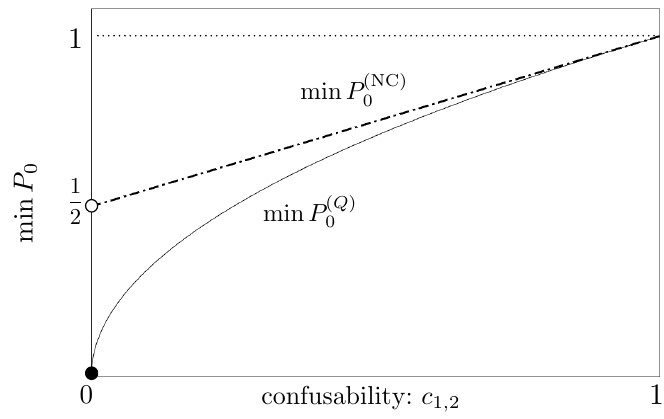
FIG. 2. The minimum value of the inconclusive error rate P 0 is plotted against the confusability c 1,2 > 0 for preparation- noncontextual theories (dashed) and quantum theory (solid). It is shown that the former is strictly greater than the latter, mean- ing that UD for quantum states contains advantages over a noncontextual model. In a noncontextual theory, the probabil- ity of inconclusive outcomes is 0 for c 1,2 = 0. There is a sharp discontinuity (see the main